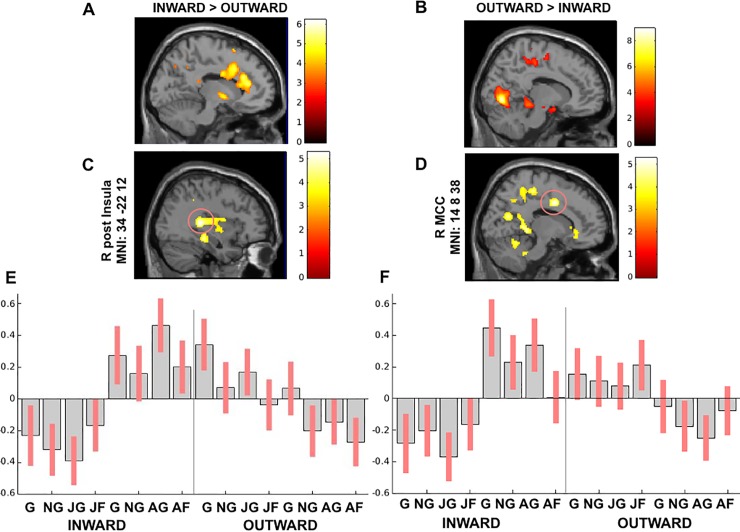
(A) Inward group > Outward group across sessions and (B) Outward group > Inward group across sessions, whole-brain analysis between groups P<0.05 FWE; (C-D) The peak signal changes that occurred in the right posterior insula and right MCC in groups x emotional acting interaction results (P<0.05 FWE cluster-level corrected). (E-F) Contrast estimates and 90% confidence intervals in the right posterior insula and in the right MCC presented for visualization purpose.